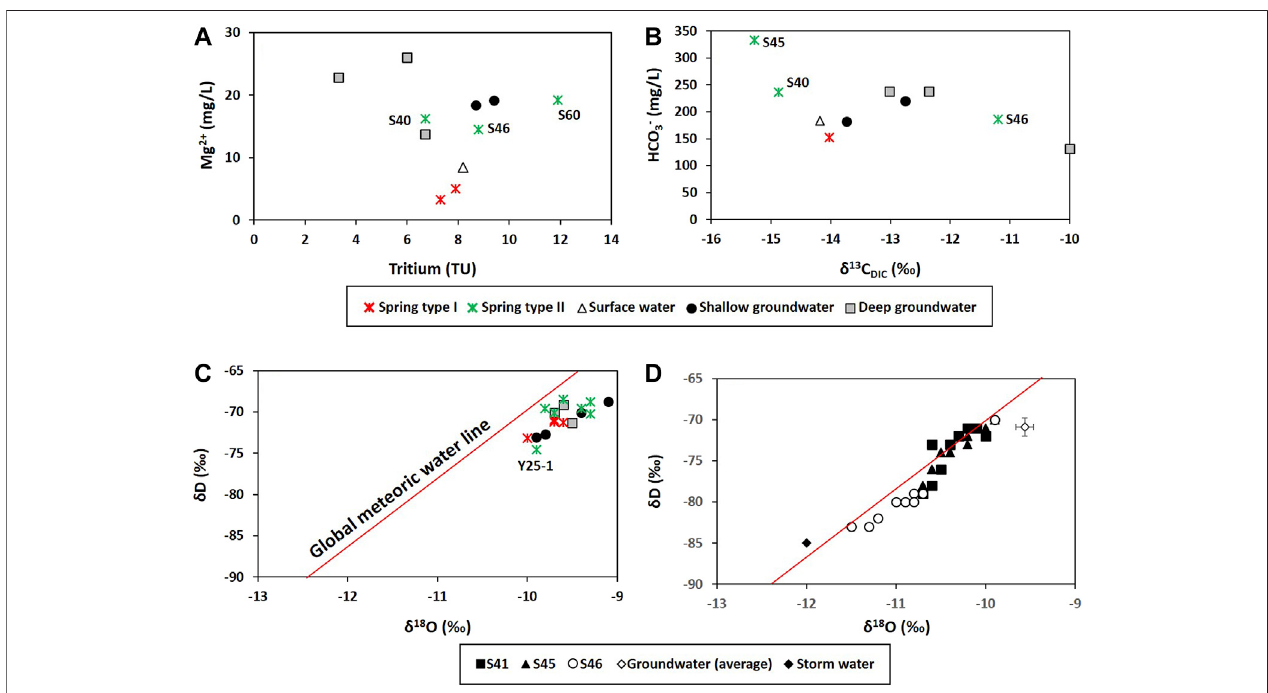
FIGURE5| Environmentalisotropiccompositions: (A) Tritiumconcentrations( n (cid:1) 11); (B) carbonisotopesofdissolvedinorganiccarbon( δ 13 C DIC ; n (cid:1) 10)collected during wet season. Hydrogen ( δ D) and oxygen isotopes ( δ 18 O) of water collected in the dry season in 1999 ( n (cid:1) 18) (C) and of three Type Ⅱ springs collected during the stormeventin2000 (D) .In (D) ,theGroundwater(average)camefromdeepgroundwaterin (C) ( δ D (cid:1) − 70.2 ‰ ; δ 18 O (cid:1) − 9.6 ‰ ; n (cid:1) 3)andwasusedtorepresentthepre- storm water (PS) for hydrograph separation in Figure 11 . Sample names are given for some Type Ⅱ springs.